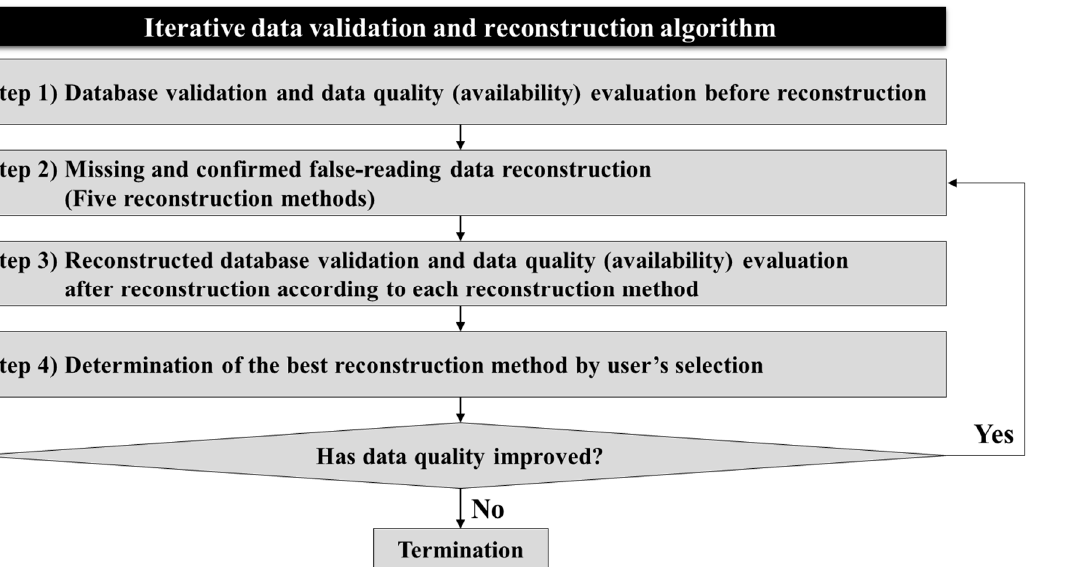
(d) Figure 6. Illustration of iterative quality control process. (a) Data validation of original dataset; (b) Reconstructed values by five reconstruction methods; (c) Data reconstruction chosen by data manager; (d) Data validation of reconstructed dataset.